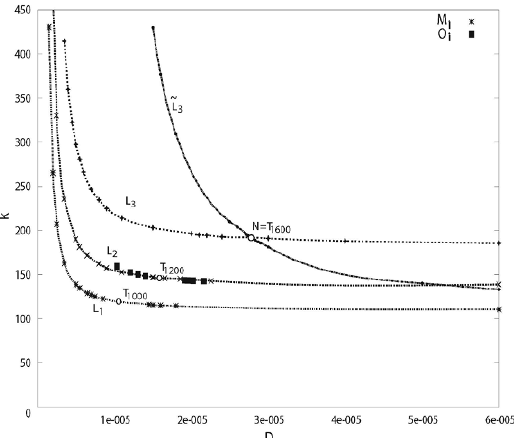
Figure 2. Calculations in the one-dimensional model. The synthesis space V = (0, a ); a =1 ( m m) for the sol-gel method and a =10 ( m m) for the solid-state method.